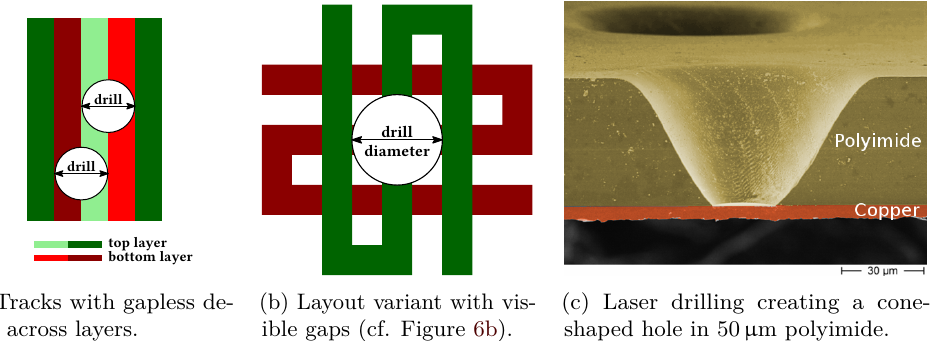
Figure 2: Geometrical considerations of track width vs. mechanical and laser